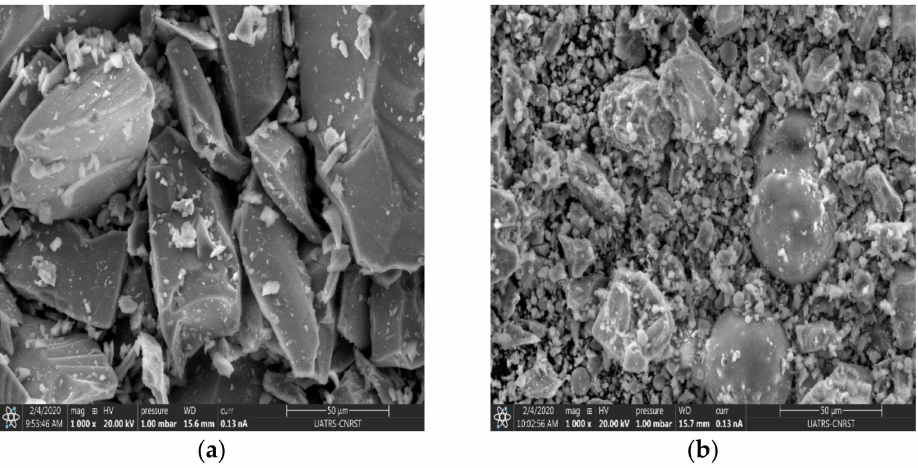
Figure 5. Scanning electron microscopy of: ( a ) Glass Powder; ( b )